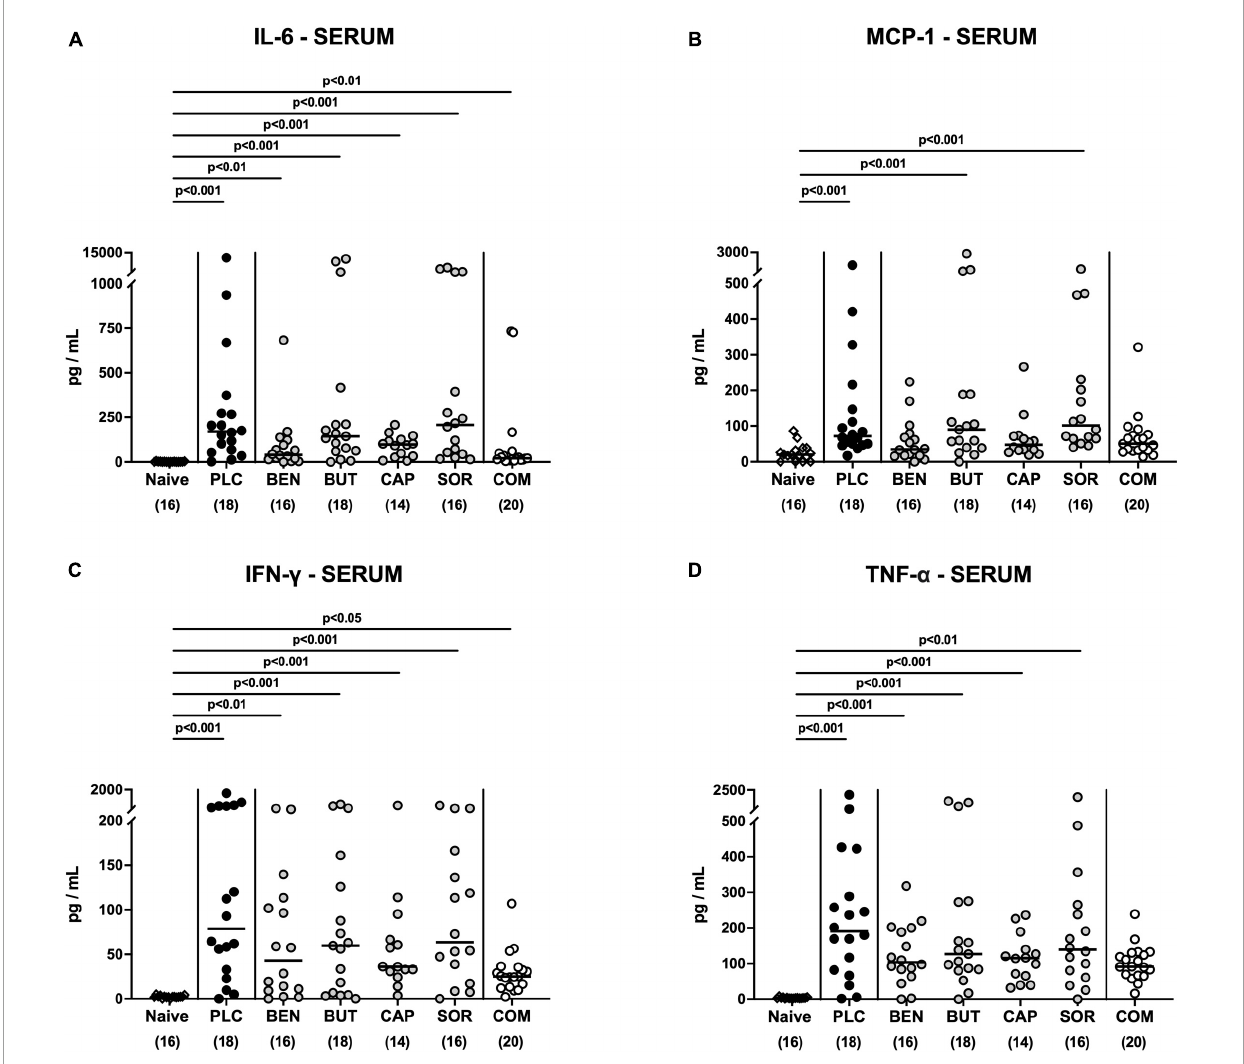
FIGURE8 Systemic pro-inflammatory mediator secretion following organic acid treatment. From day 2 until day 6 post-infection, the mice received an oral treatment with benzoic acid (BEN), butyric acid (BUT), caprylic acid (CAP), sorbic acid (SOR), a combination of all acids (COM) or placebo (PLC), whereas naive mice served as untreated and uninfected controls. (A) IL-6, (B) MCP-1, (C) IFN- γ , and (D) TNF- α concentrations were measured in serum samples taken on day 6 post-infection. Medians (black bars), significance levels ( p values) calculated by the ANOVA test with Tukey’s post-correction or by the Kruskal–Wallis test and Dunn’s post-correction and the total mice numbers (in parentheses) are given. Data were pooled from three independent